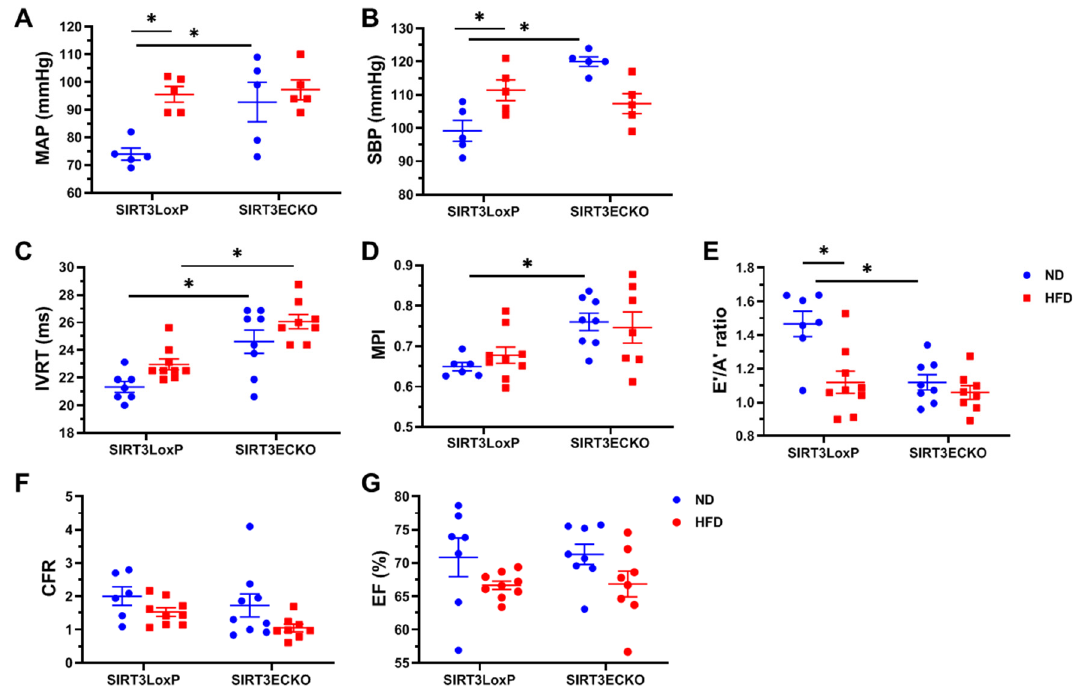
Figure 4. Loss of endothelial SIRT3 exacerbates HFD-induced changes in hemodynamics and diastolic function. ( A , B ) HFD results in a significant increase in the MAP and SBP in the female SIRT3 LoxP mice when compared to the ND-fed control mice. HFD does not further increase the blood pressure in the female SIRT3 ECKO mice. N = 5 mice. * p < 0.05 ( C ) HFD further prolongs the IVRT when compared to the SIRT3 LoxP mice fed a ND. * p < 0.05 ( D ) HFD does not alter the MPI in either SIRT3 LoxP or SIRT3 ECKO mice. * p < 0.05 ( E ) HFD leads to a significant decrease in the E’ / A’ ratio in the female SIRT3 LoxP mice when compared to the ND-fed control mice, but HFD does not decrease the E’ / A’ ratio in the female SIRT3 ECKO mice. N = 7–9 mice. * p < 0.05. ( F ) HFD does not significantly decrease the coronary flow reserve (CFR). N = 6–9 mice. ( G ) The ejection fraction ( E , F ) was not di ff erent between the female SIRT3 LoxP and SIRT3 ECKO mice when fed either ND or HFD. N = 7–9 mice.